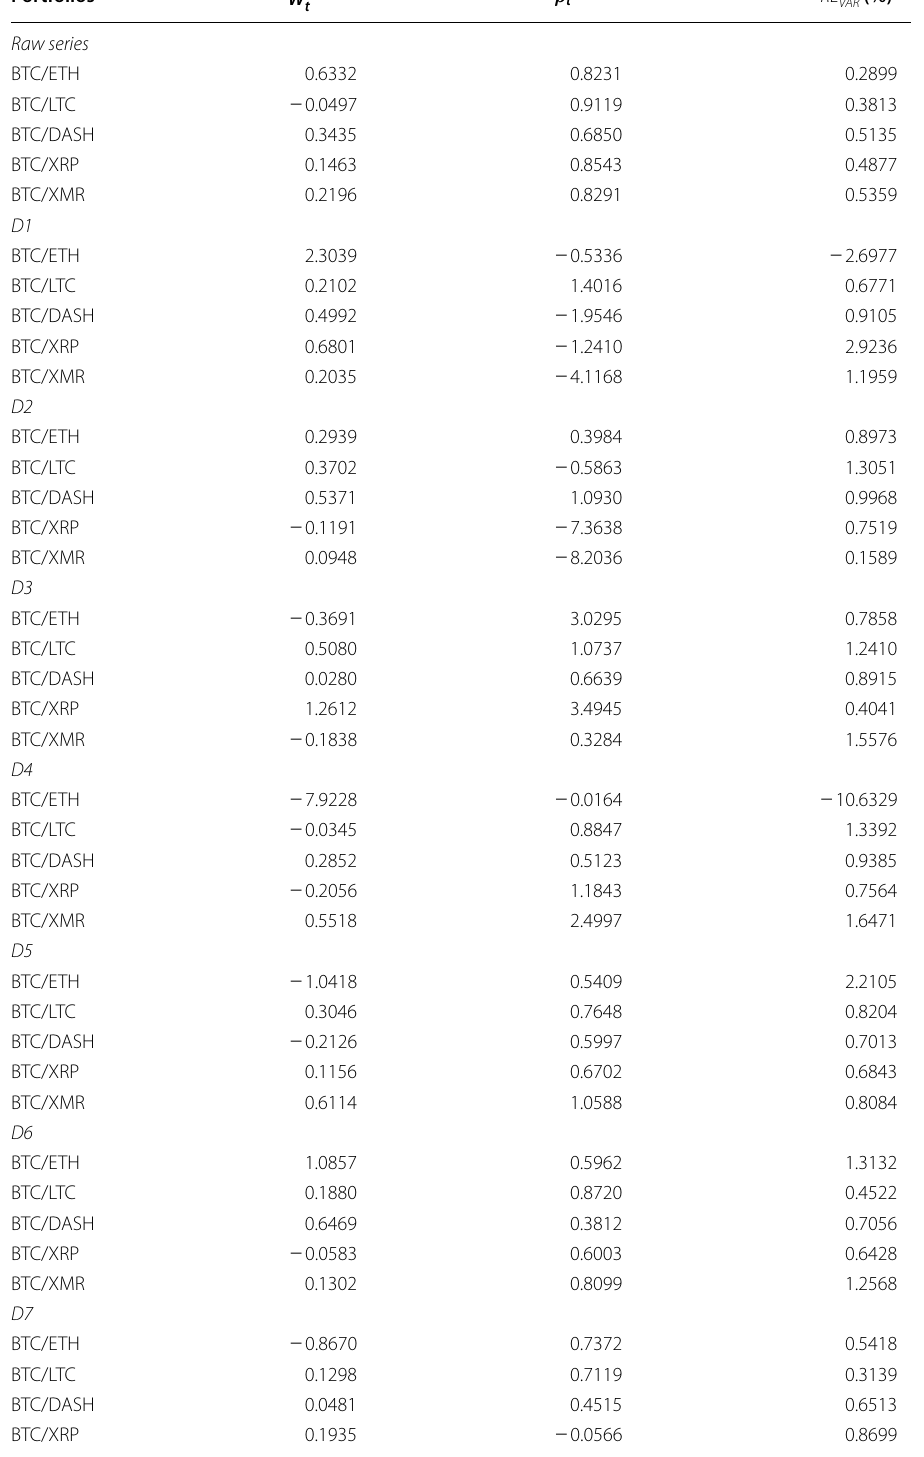
Table 2 Optimal weights, hedge ratios and hedging effectiveness under different scales